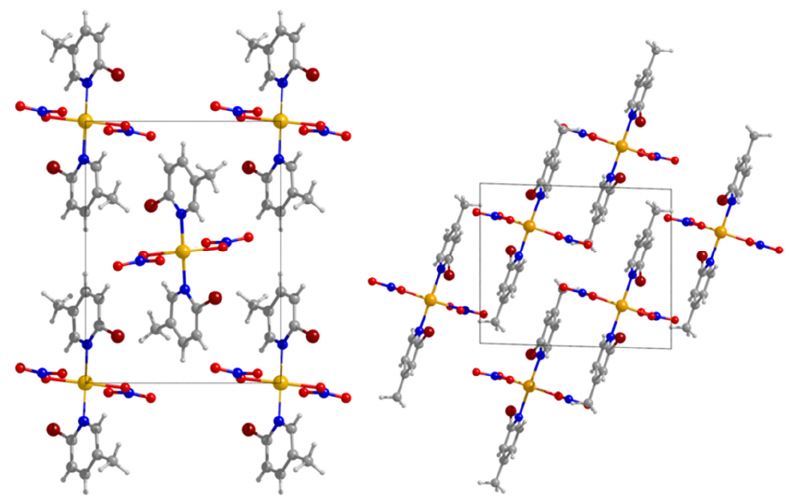
Figure 1. Projection of the crystal structures of [Cu(L) 2 (NO 3 ) 2 ]. ( left ): CuL 1 , L 1 = 2-bromo-5- methylpyridine complex in P 2 1 /c; ( right ): CuL 2 , L 2 = 2-bromo-4-methylpyridine derivative in P 1, both viewed along the crystallographic a axis. Yellow balls represent Cu atoms, light red = O, blue = N, grey = C, white = H, and dark red = Br atoms.